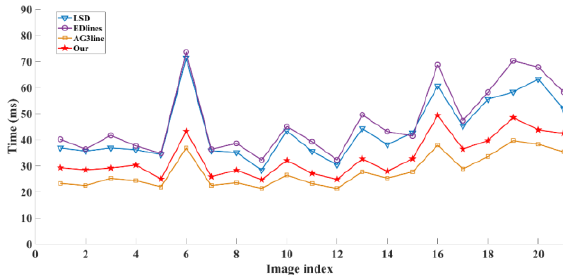
Figure 15. The computation times of different methods on dataset images.